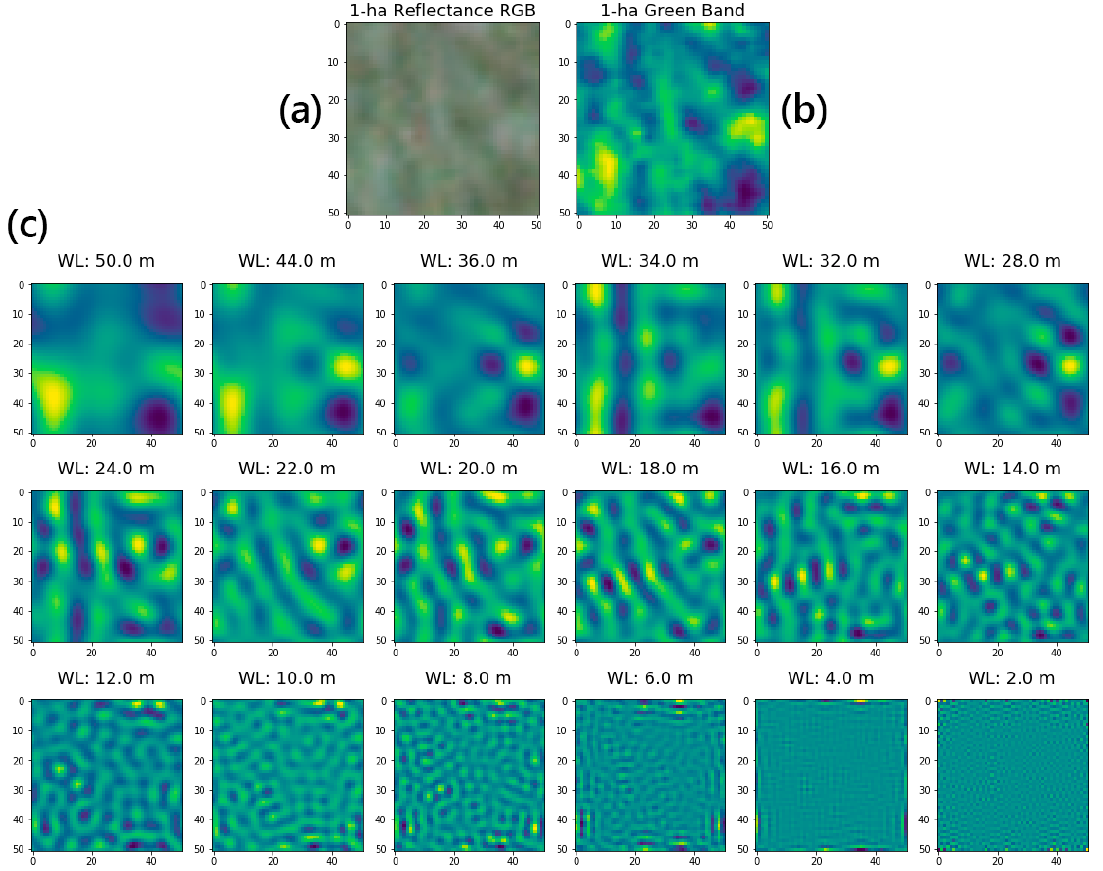
Figure 3. ( a ) The Planet Dove red, green, blue (RGB) and ( b ) its green channel of a 1 ha image subset, ( c ) the latter decomposed into its Fourier components at di ff erent wavelengths (WLs). Real-space visualizations of the component textures of the patch are displayed. The radial power spectra components, which are used as features, measure the amount of signal in the image patch allocated to each component length scale.